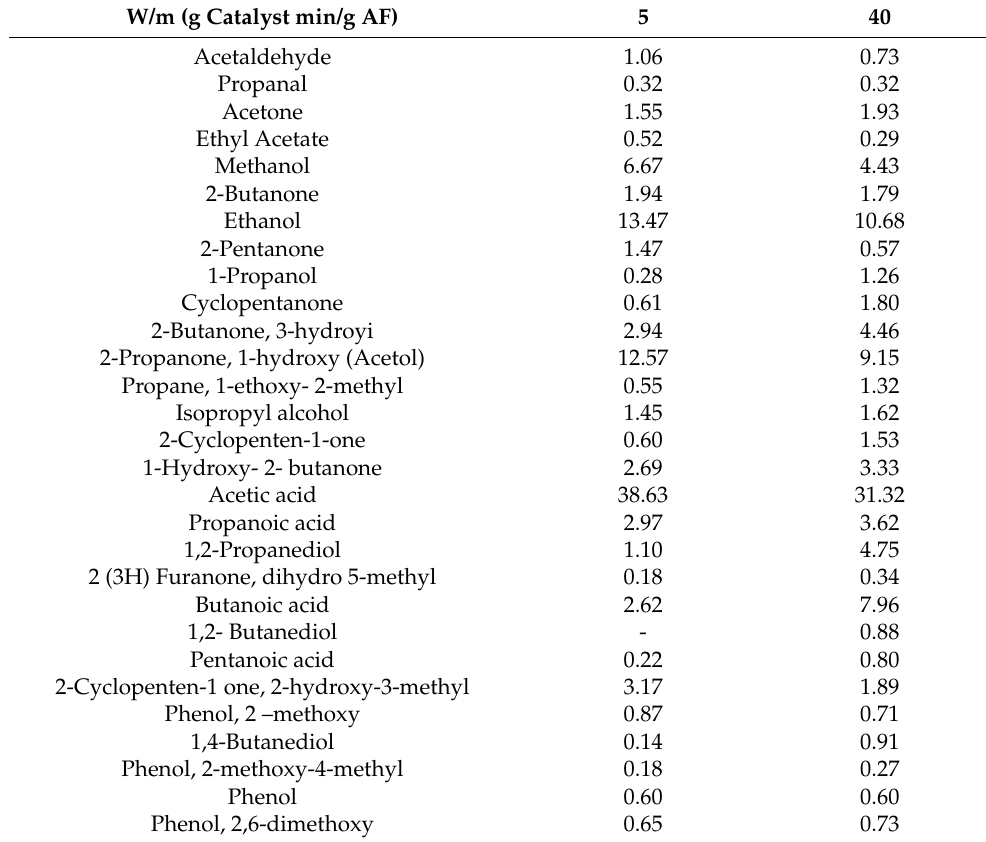
Table 7. Results of the product liquid (in area FID %) obtained in the APR experiments of a real aque- ous fraction of bio-oil (T = 227 ◦ C, 40 bar, Ni-Co/Al-Mg catalyst, 1 mL/min aqueous feeding